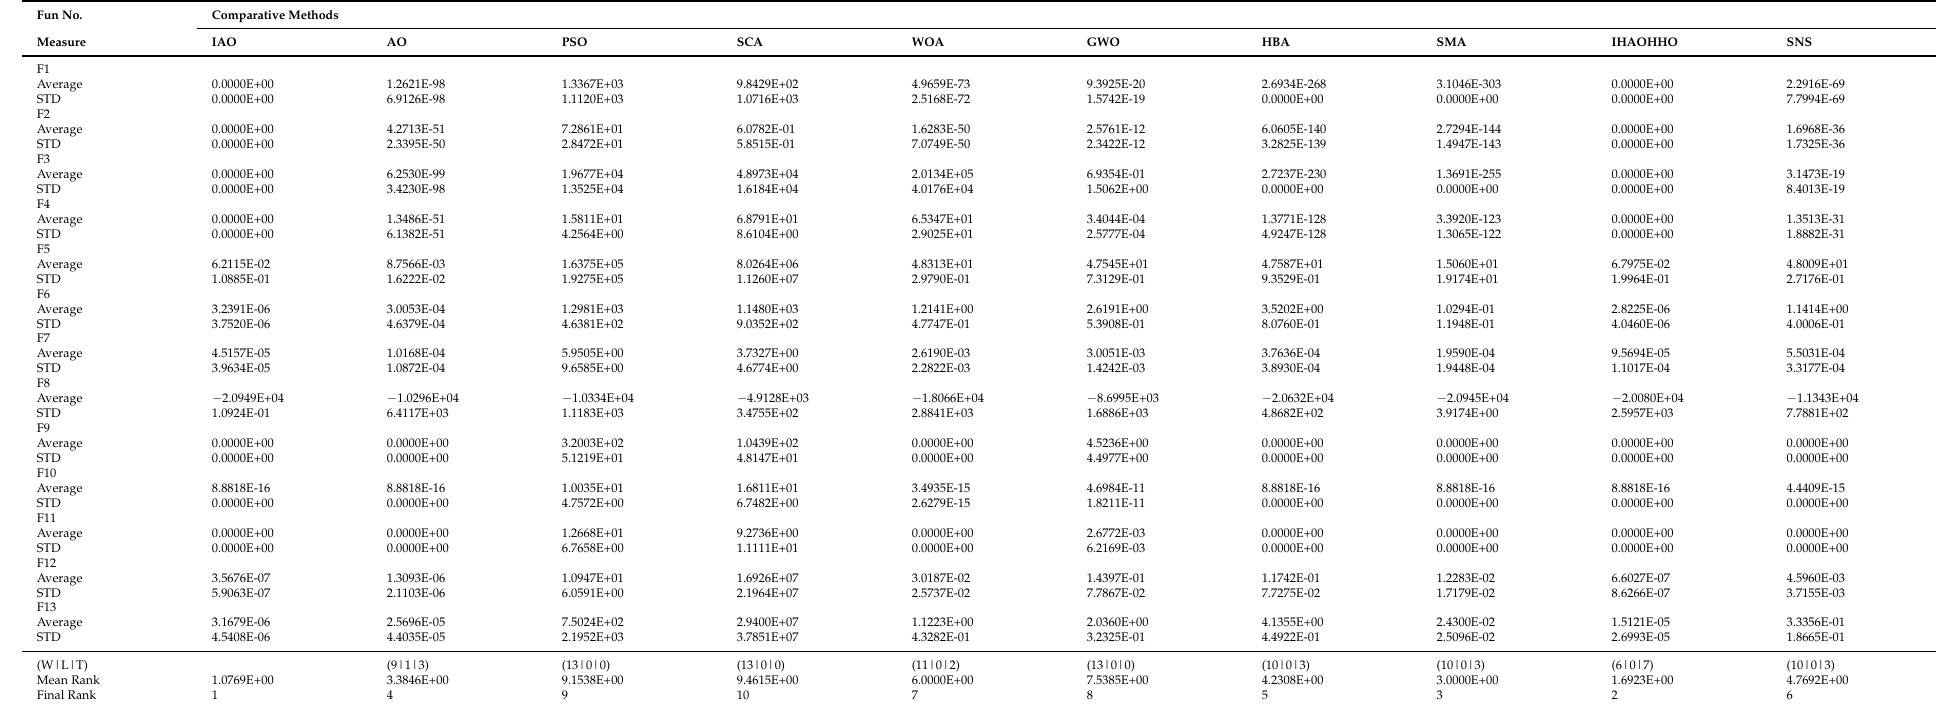
Table 6. Results of the comparative methods on classical test functions (F1–F13); the dimension is fixed to 50.